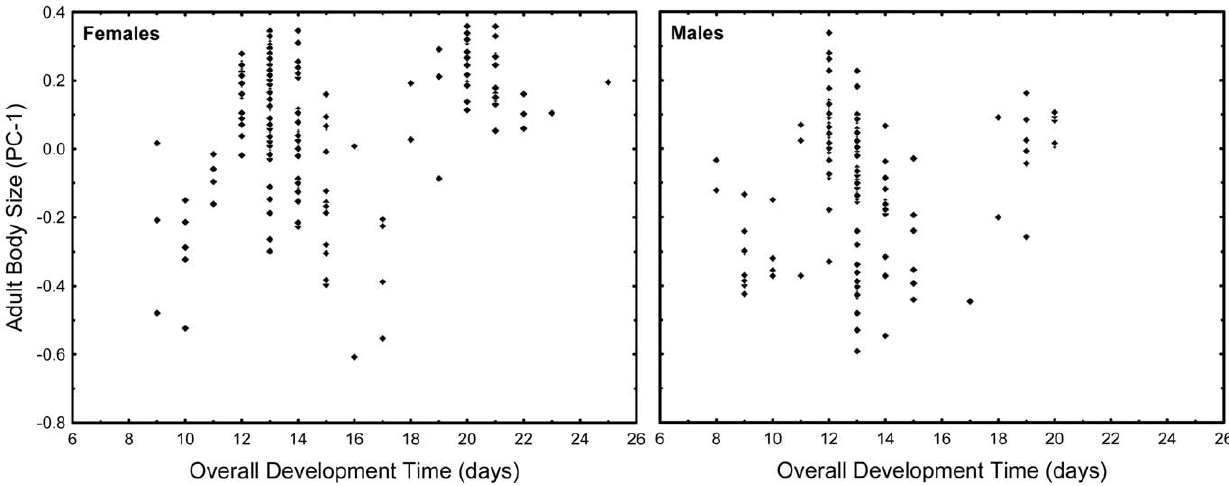
Figure 3. Adult size variation in O.caspius . Variation in adult size (PC-1) O. caspius with respect to larval development time (time from hatching to adult emergence). Data pooled over all experimental cups and treatments.